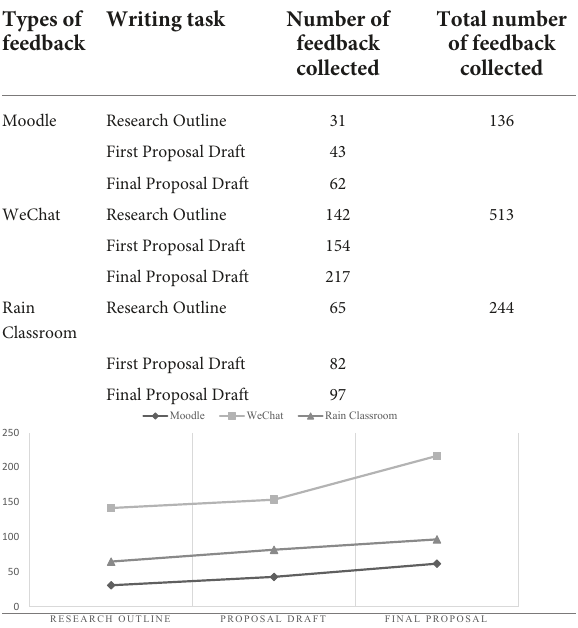
TABLE 3 Number of peer feedback